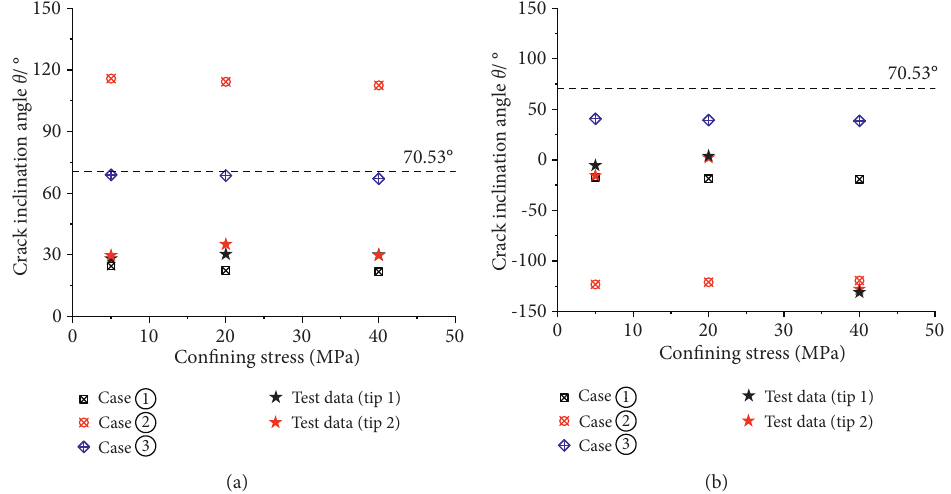
Figure 16: Comparison between the test results and theoretical predictions of initiation angle. (a) β � 30 ° . (b) β � 60 °